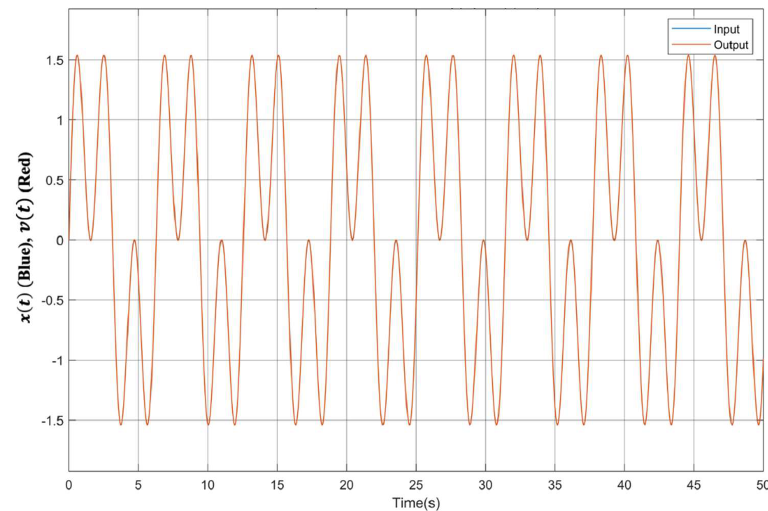
Figure 12. Response to Periodic Input with Transform and